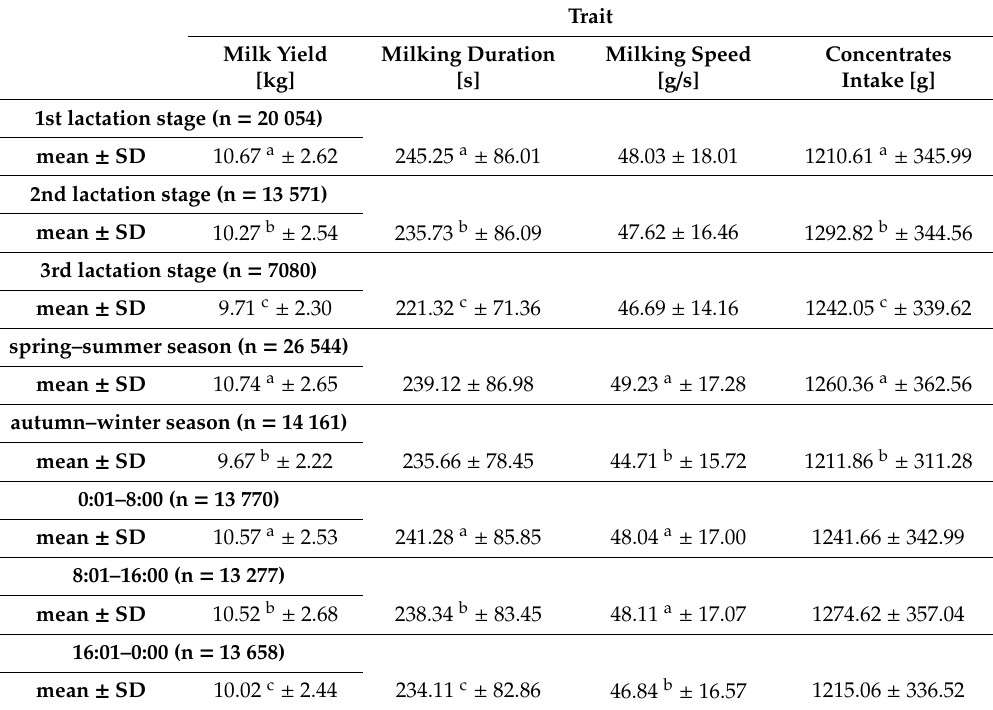
Table 6. Means and standard deviations of the considered traits for single milkings in the groups designated by lactation stage, calving season and time of